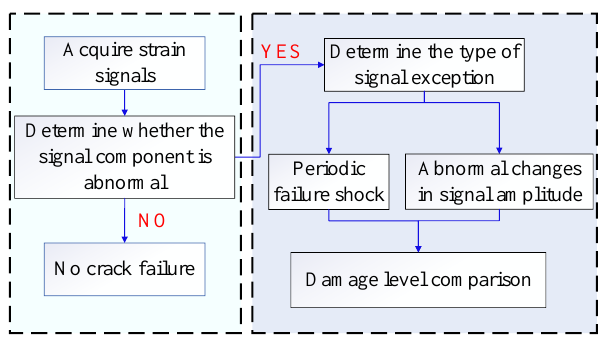
Figure 23. Damage discrimination flow chart.